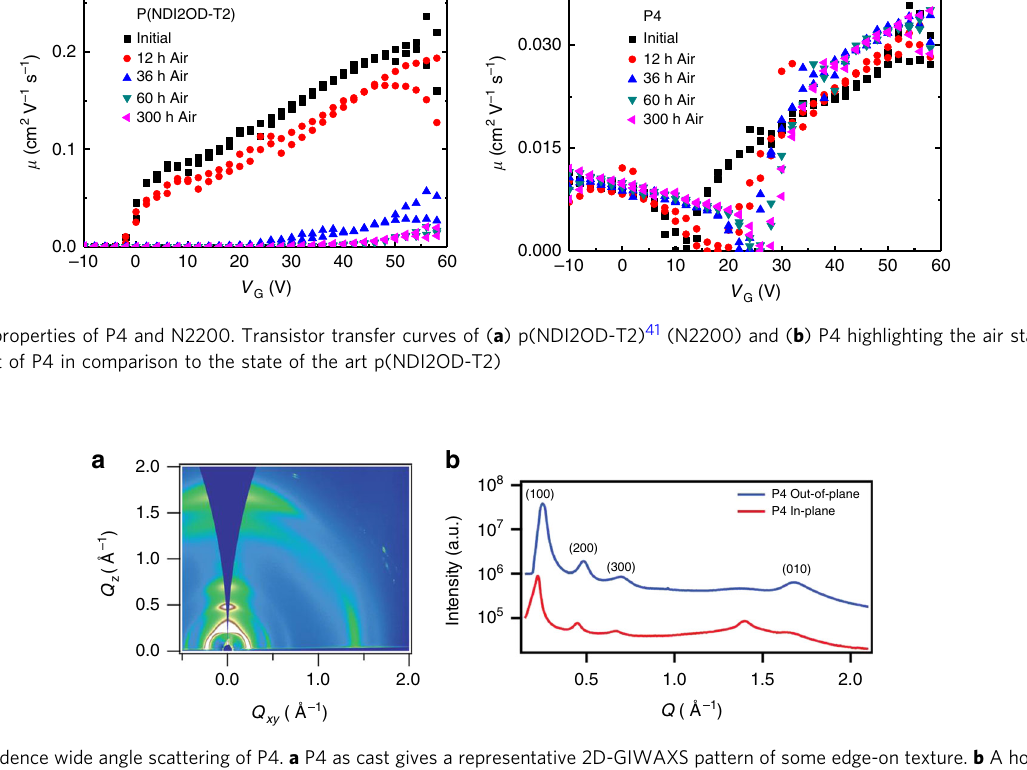
Fig. 6 Grazing-incidence wide angle scattering of P4. a P4 as cast gives a representative 2D-GIWAXS pattern of some edge-on texture. b A horizontal 1D linecut of P4 as cast showing the strong layered ordering (100), (200) and the (010)